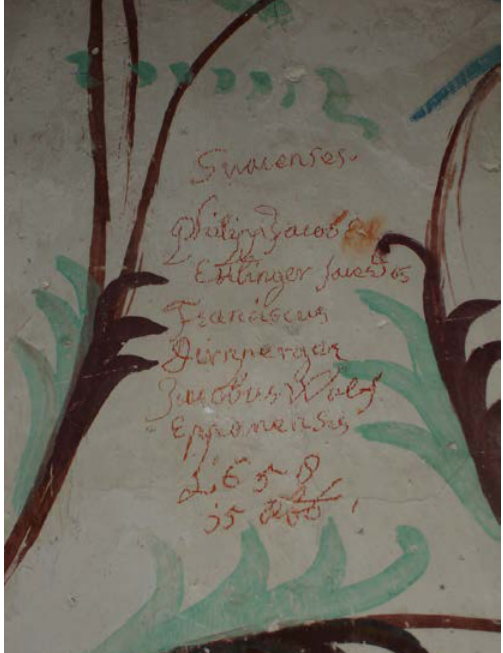
Figure 2 – Graffiti by a group of wine merchants in Frundsberg Castle, naming one of them as ‘Eppanensis’ (third line from below). Photo by Romedio Schmitz-Esser. Courtesy of the